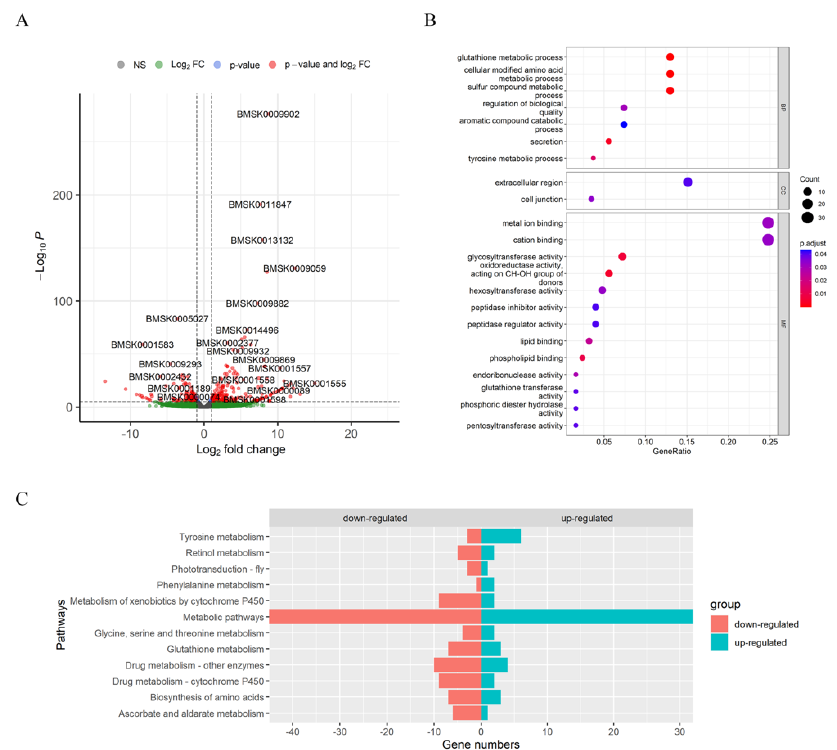
Figure 4. RNA-sequencing data uncovered differences between BmAbl1 - and Nistari in transcription level. ( A ) The volcano plot showed 657 differentially expressed genes (DEGs) between BmAbl1 - and Nistari . Compared to Nistari , 264 genes were up-regulated and 393 genes were down-regulated in BmAbl1 - . Red dots indicate DEGs, and green dots indicate non-DEGs; ( B ) GO enrichment analysis result; ( C ) KEGG enrichment analysis results. Blue bars indicate the up-regulated genes in enriched terms. Red bars indicate the down-regulated genes in enriched terms.